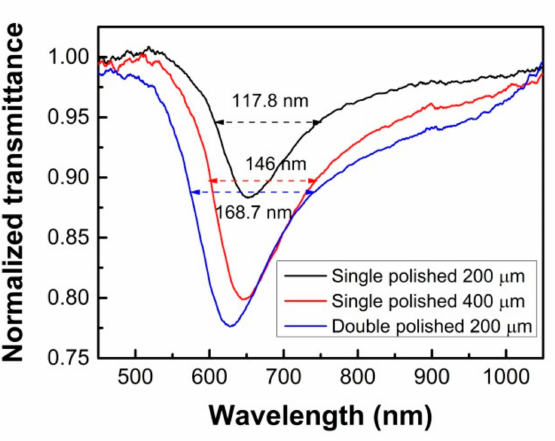
Figure 8. The normalized transmission spectra for the single and double-sided polished POF-based SPR probes in the external medium with RI of